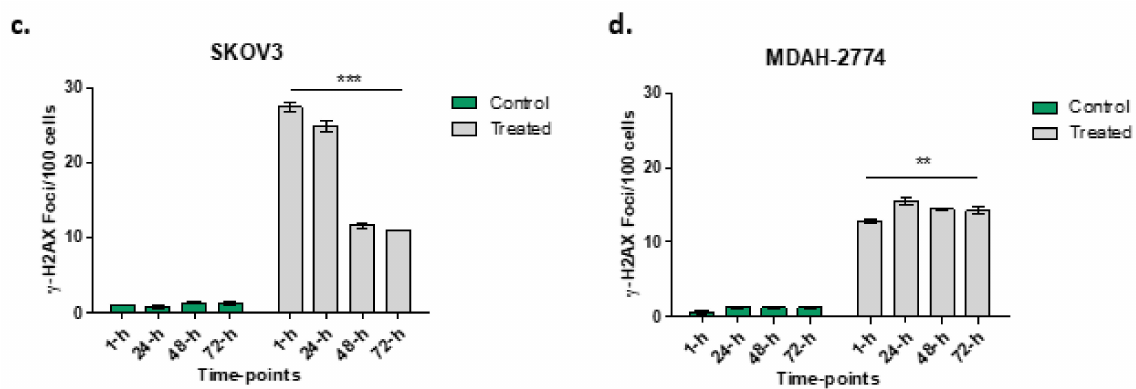
Figure 4. Numbers of γ -H2AX foci at different time points in PEO1 (panel a ), PEO4 (panel b ), SKOV3 (panel c ) and MDAH-2774 (panel d ) following rucaparib treatment. Comparisons between 1 h and 72-h of treatment undertaken: *** p < 0.0001, ** p = 0.0095.